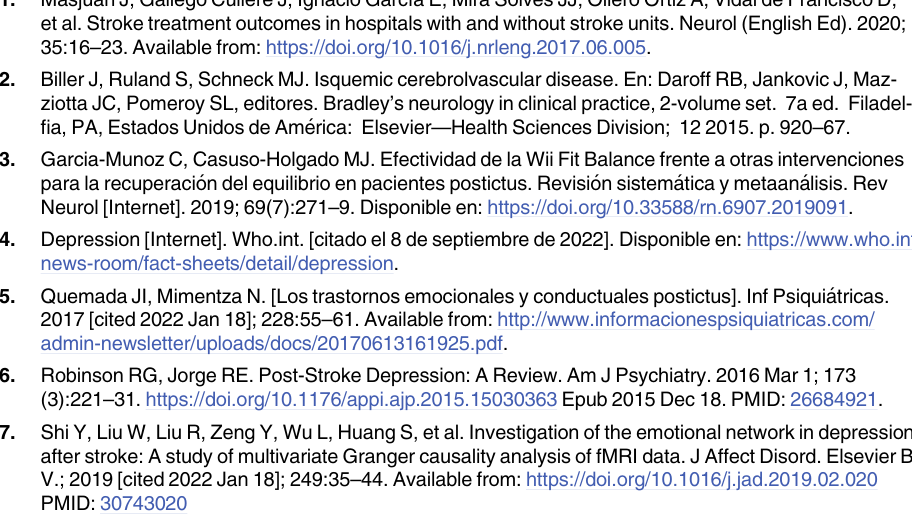
S1 Fig. Plan of study screening and selection